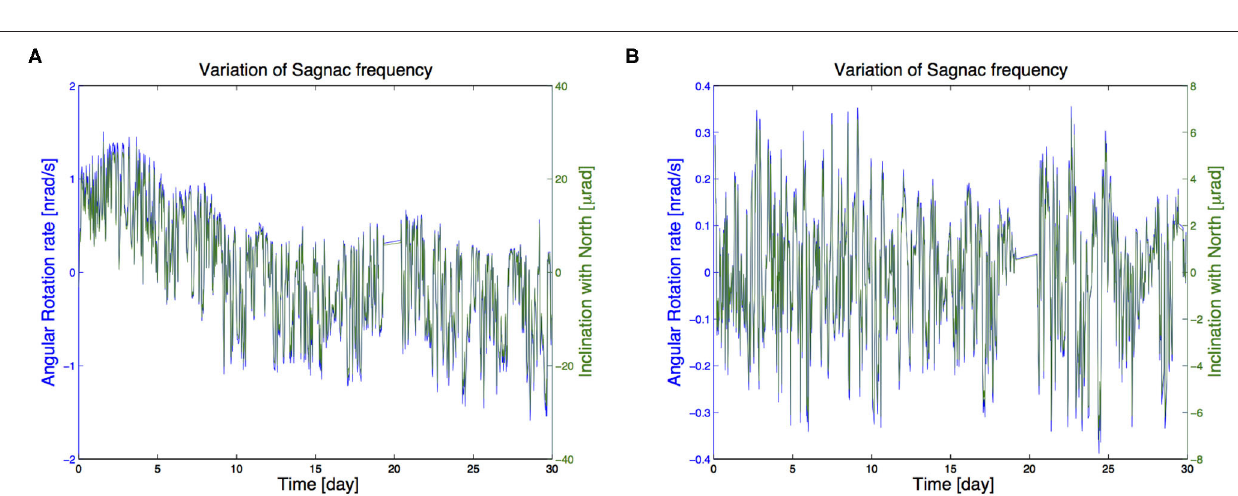
FIGURE 7 | Linear regression model analysis scheme: with statistical means, the parameters ξ and µ , related to the reduction of the laser dynamic systematic, and all other parameters should take into account the environmental monitors are evaluated to determine ω s .